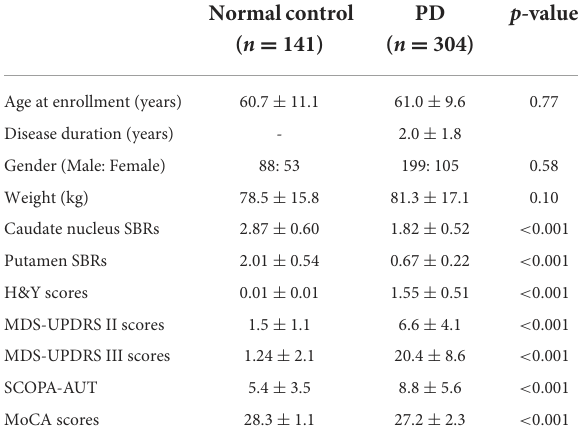
TABLE 1 Characteristic features of the NC group and the PD